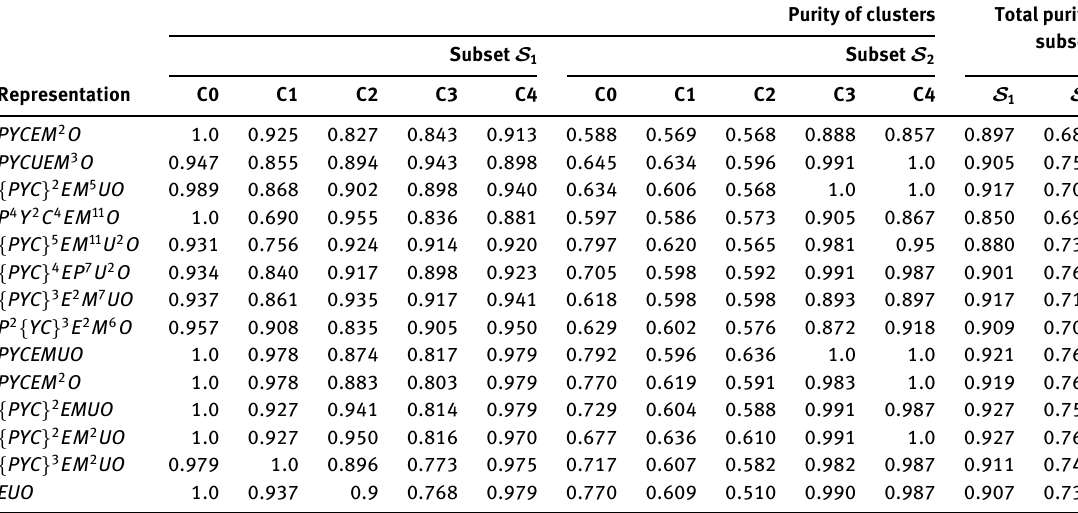
Table 2: Partitions of BBC NEWS (Subsets 𝒮 1 and 𝒮 2 ) Obtained by k-Means with Different Function ℱ , Entailing Different Document Representations.